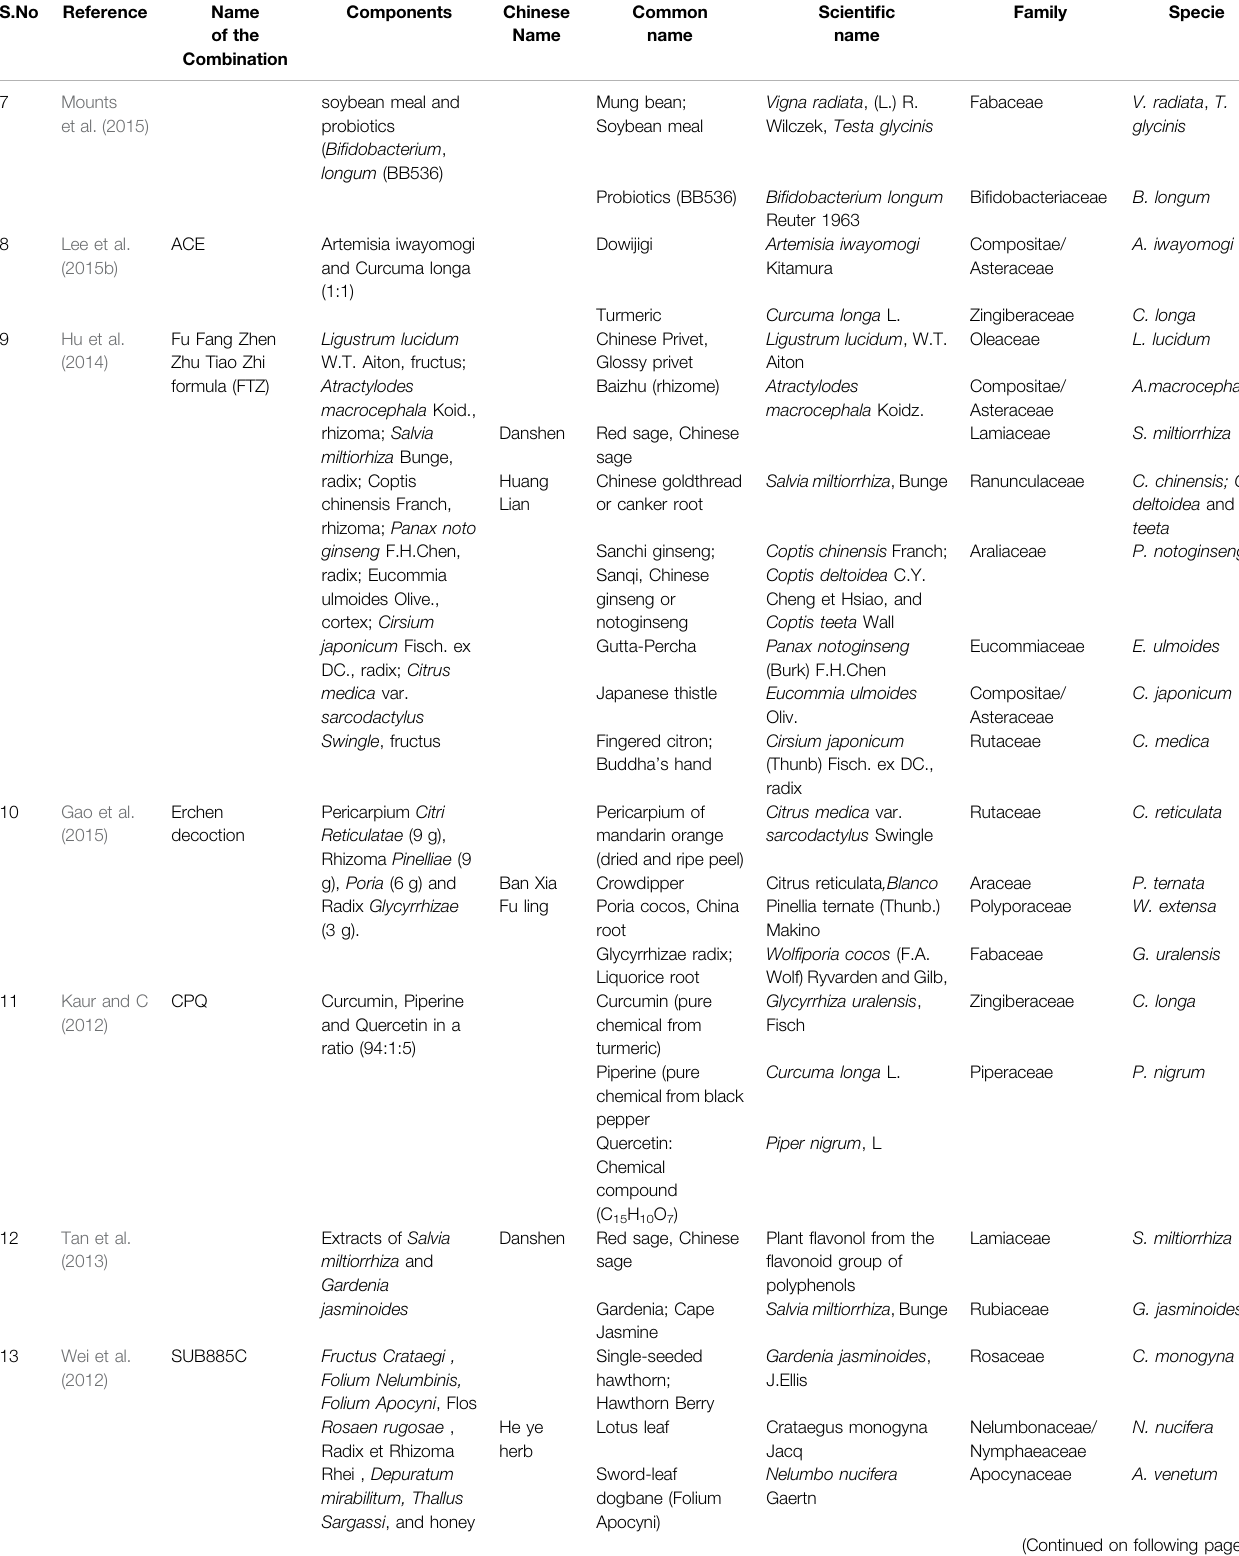
TABLE 1 | ( Continued ) Taxonomic classi fi cation of all the polyherbal combinations reviewed in animal